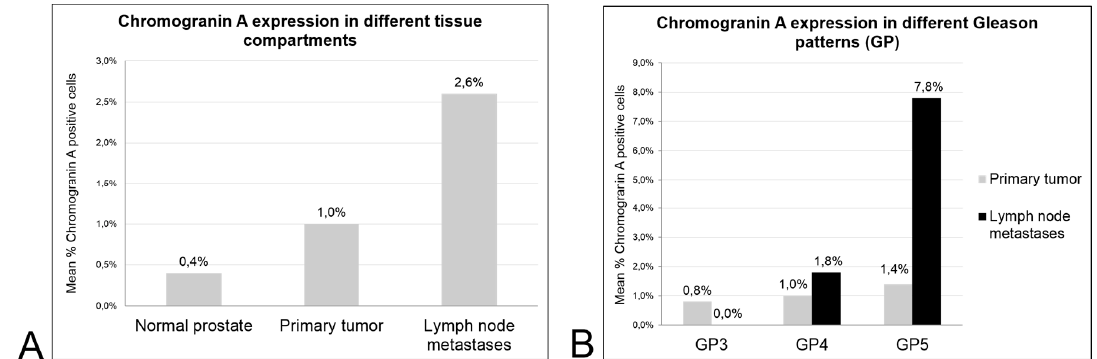
Figure 1. Mean density of Chromogranin A positive cells is significantly different between normal prostate glands, primary prostate cancer and matched lymph node metastases (( A ) p < 0.001). The difference between the Gleason patterns is not significant (( B ) p > 0.05).